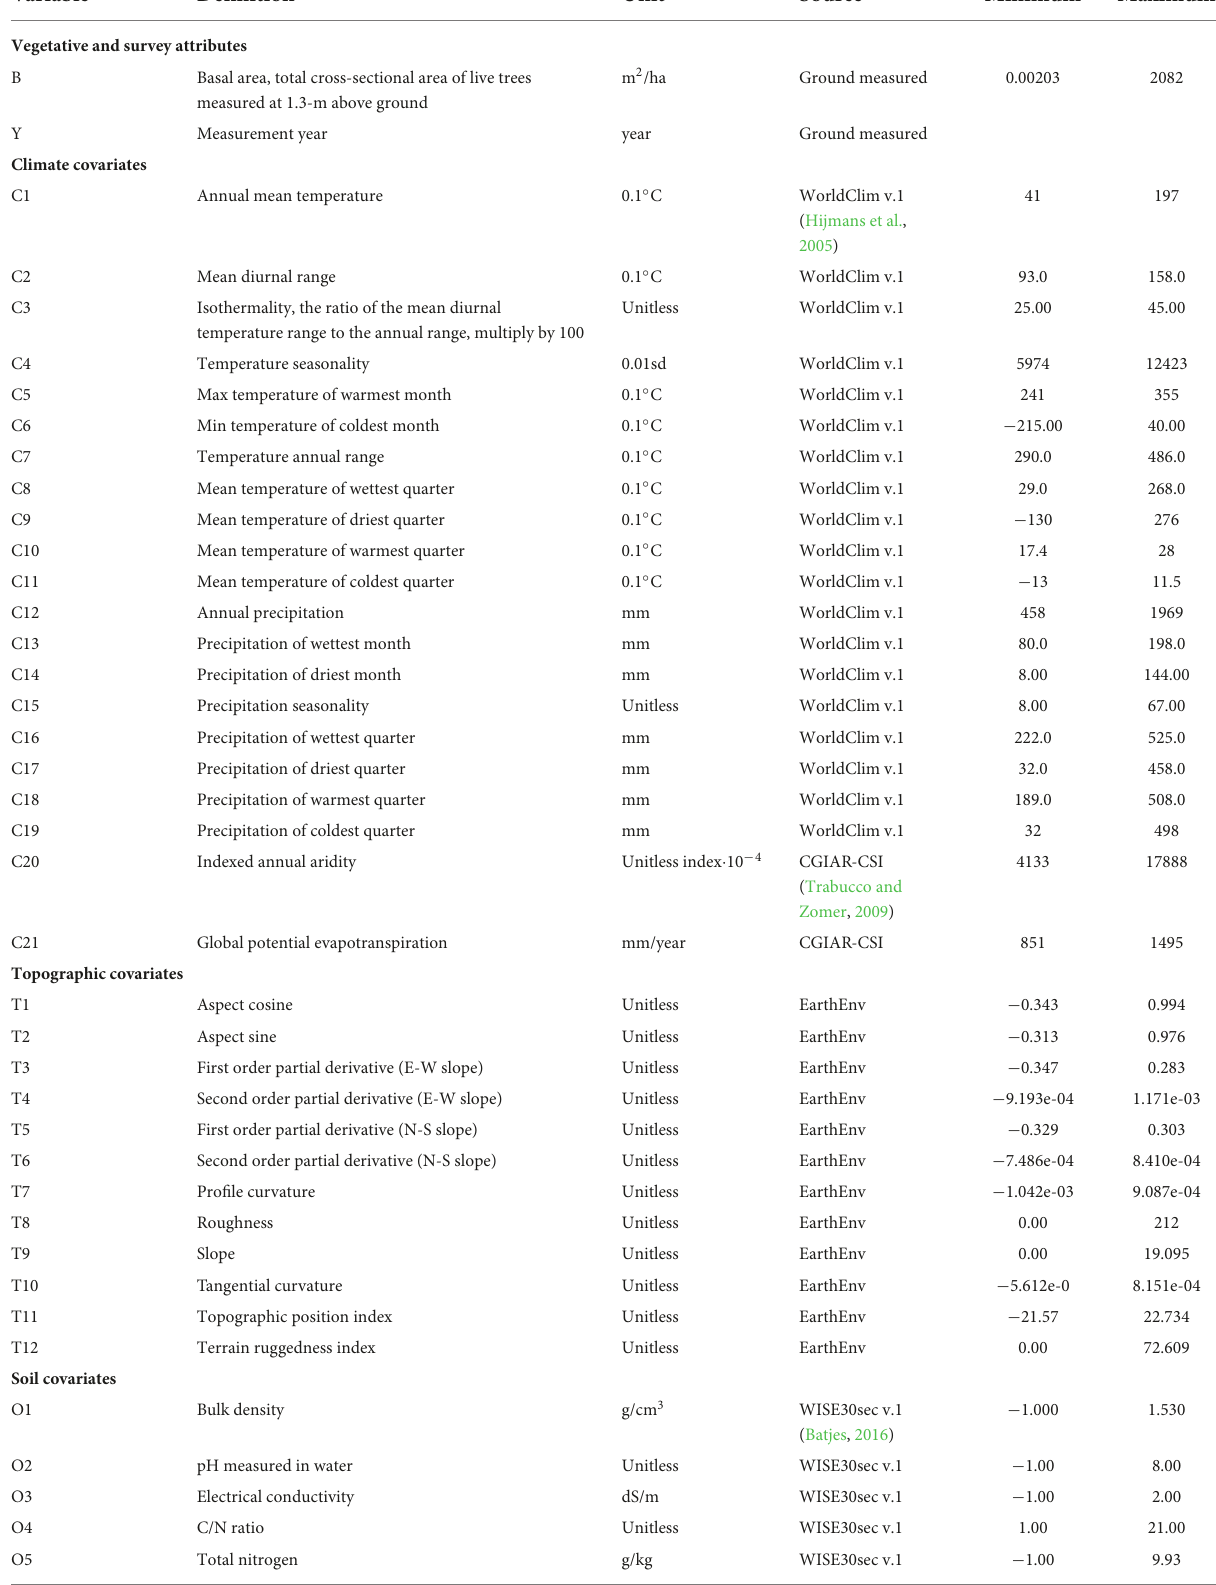
TABLE 1 Definition and units of the environmental and bioclimatic covariates (Hijmans et al., 2005) extracted to the FIA plot locations.